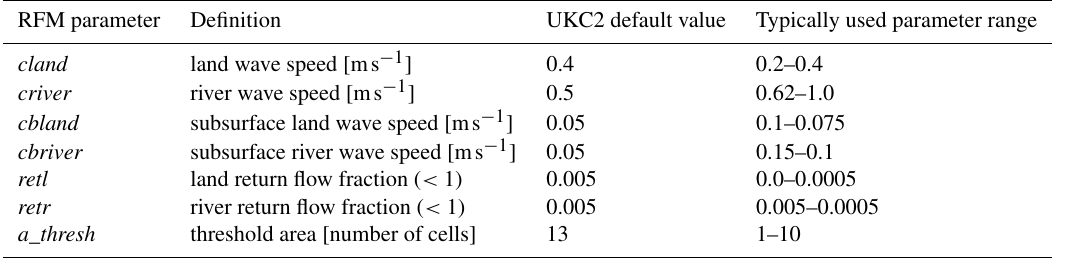
Table C3. Parameters available to define the RFM river routing algorithm (see Bell et al., 2007, for details), and values used within UKC2. Typically used parameter value ranges from global to regional applications is also shown for reference.